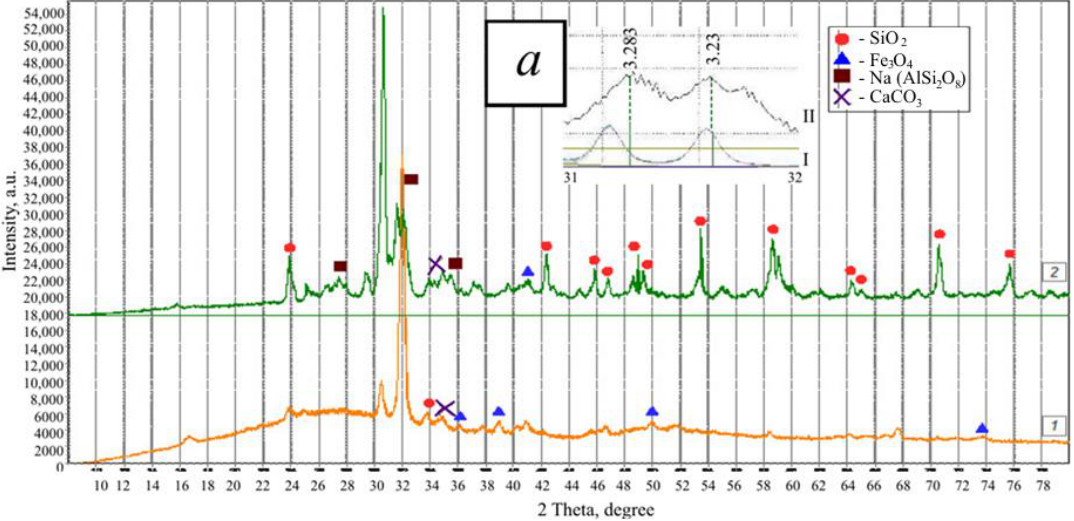
Figure 2. XRD patterns of fly ash ( 1 ) and slag ( 2 ) of the Grozny TPP, a— comparison of the interplanar distances of Na (AlSi 3 O 8 ) in nature (I) and in the slag (II).